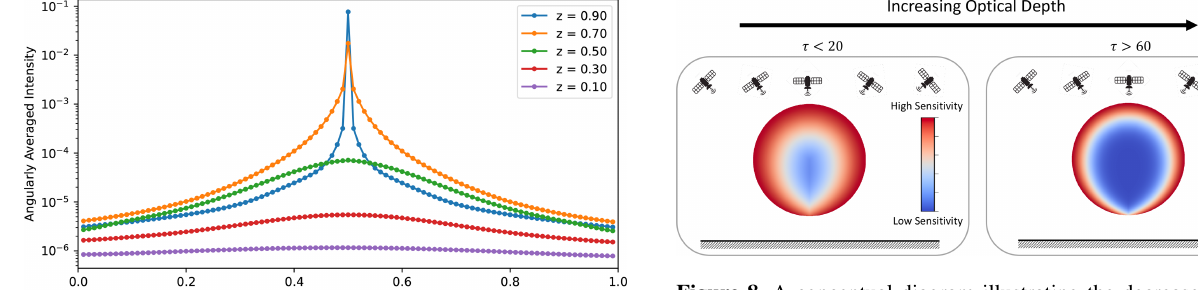
Figure 8. A conceptual diagram illustrating the decrease in mag- nitude of the Jacobian elements with distance from the sensors through a transect through a homogeneous spherical cloud. The mismatch in the magnitude of the Jacobian elements between the outer edges and the interior of the cloud increases as the optical dimension of the cloud